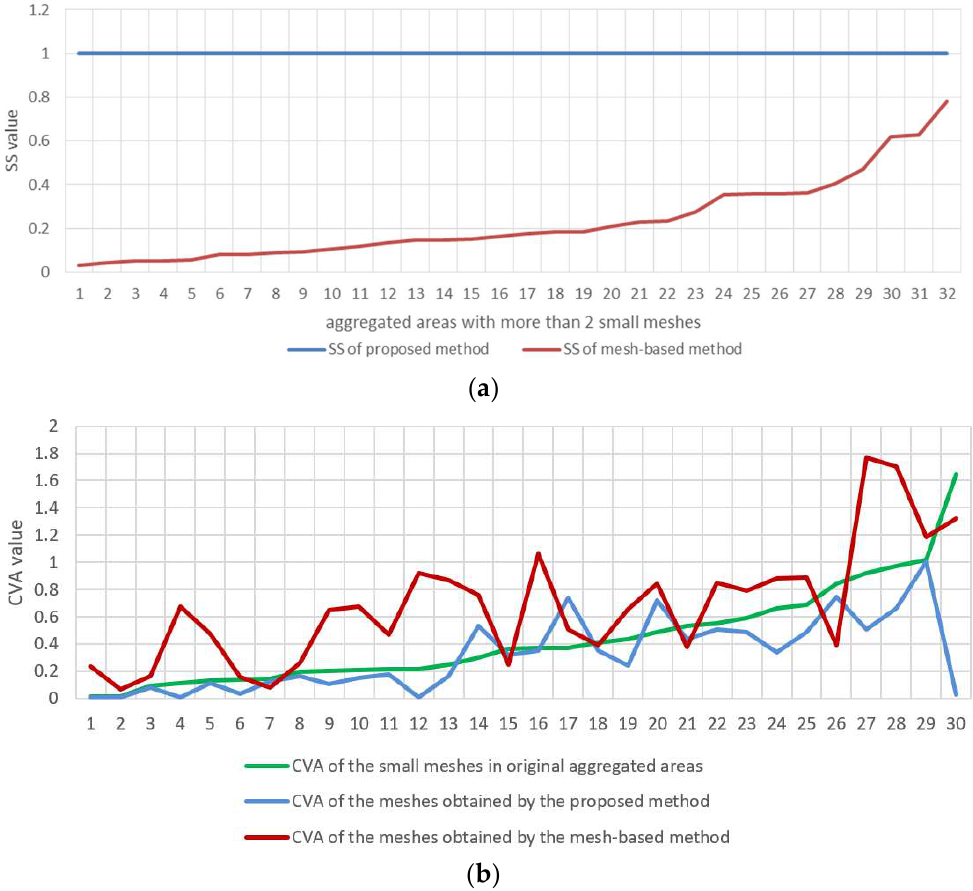
Figure 13. ( a ) Comparison of SS values for each method in 32 aggregated areas with more than two small meshes; and ( b ) comparison of CVA values for each method in 30 aggregated areas with more than two small meshes (not including 2 aggregated areas for which the final selection result is a single mesh).